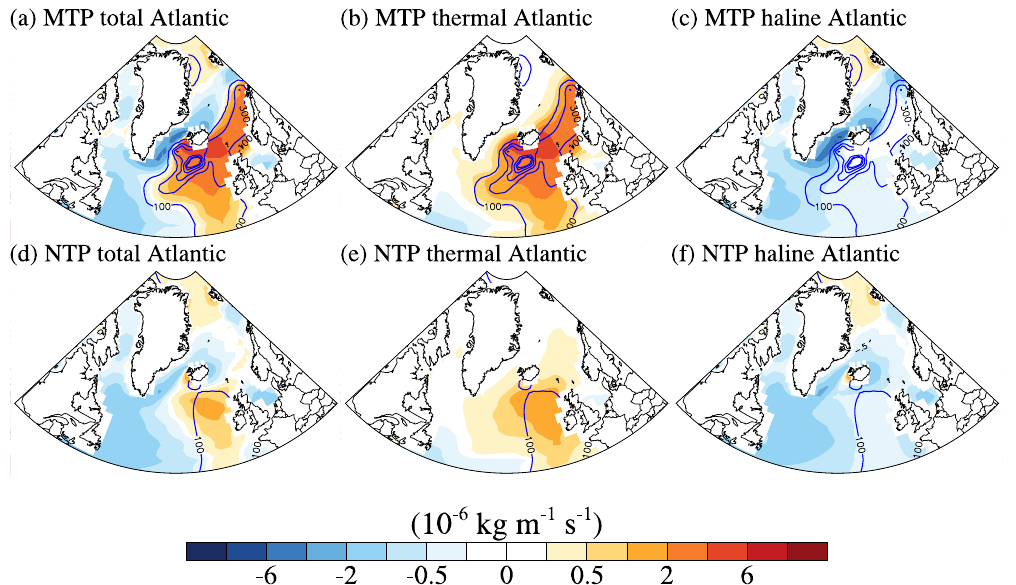
Figure 5. The North Atlantic annual mean (a, d) total density flux (shading; positive means flux makes water denser), (b, e) the thermal density flux, (c, f) the haline density flux, and the winter mixed-layer depth (blue contour, contour interval: 200m) in the MTP run ( a, b, c ) and NTP ( d, e, f